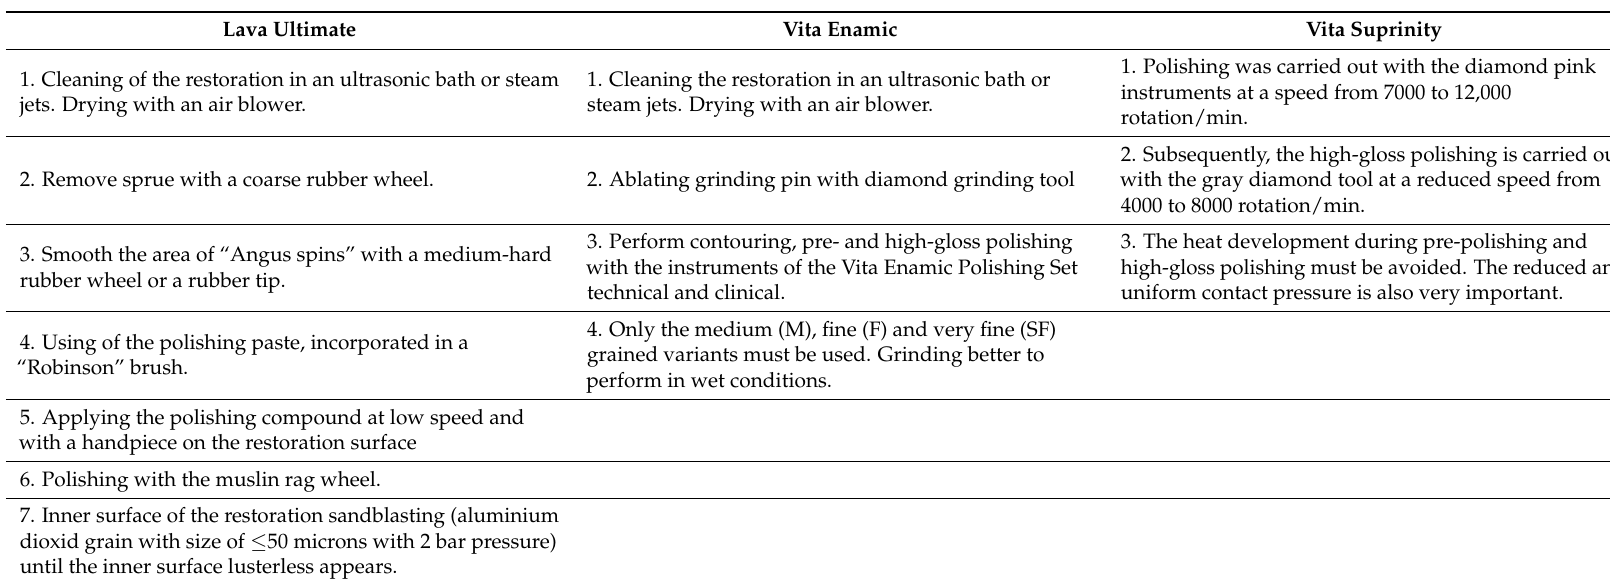
Table 8. Polishing protocol was performed according to the information provided by the